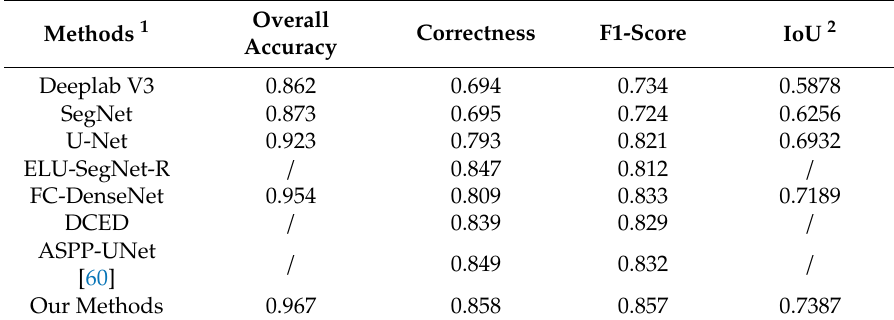
Table 4. Quantitative comparison of Nested SE-Deeplab with other deep-learning models for the testing set.